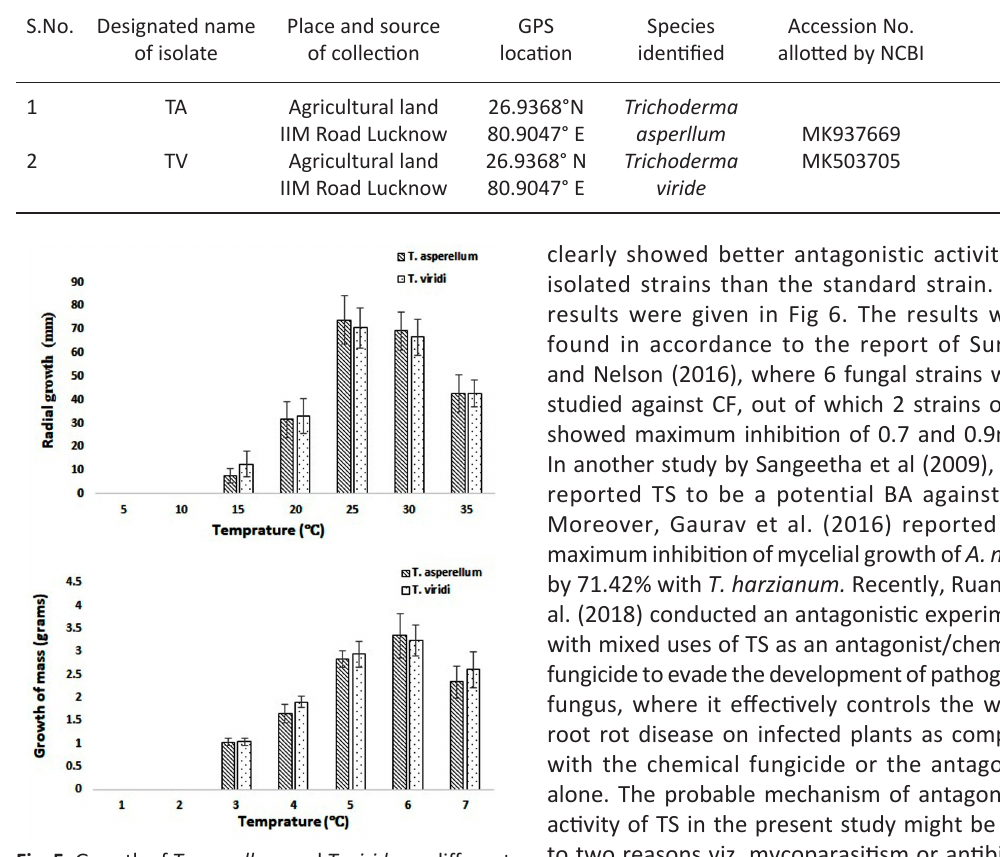
Fig. 5. Growth of T. asperllum and T. viride on different